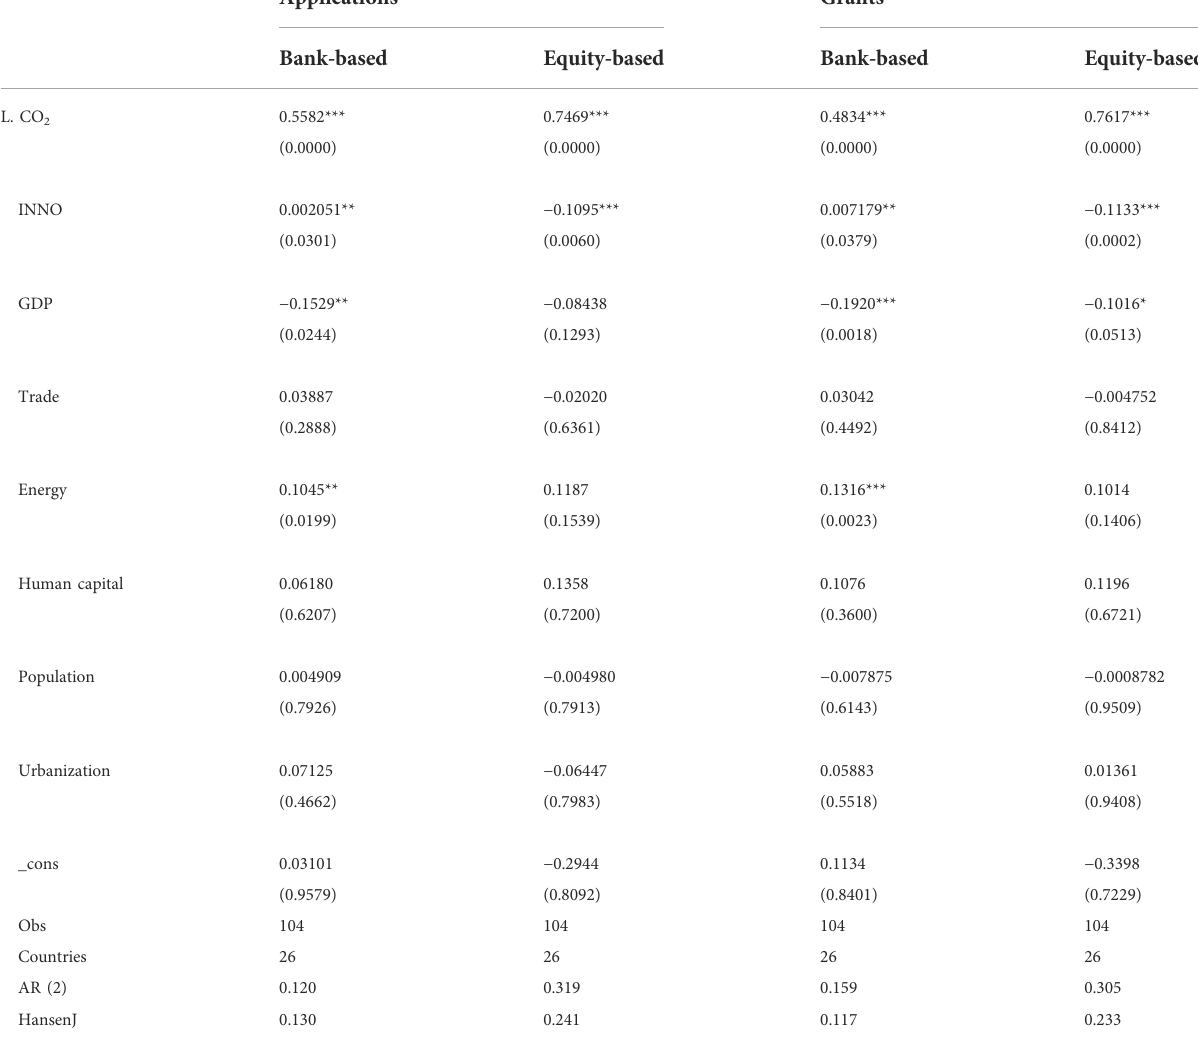
TABLE 8 Financial structure, innovation, and environment